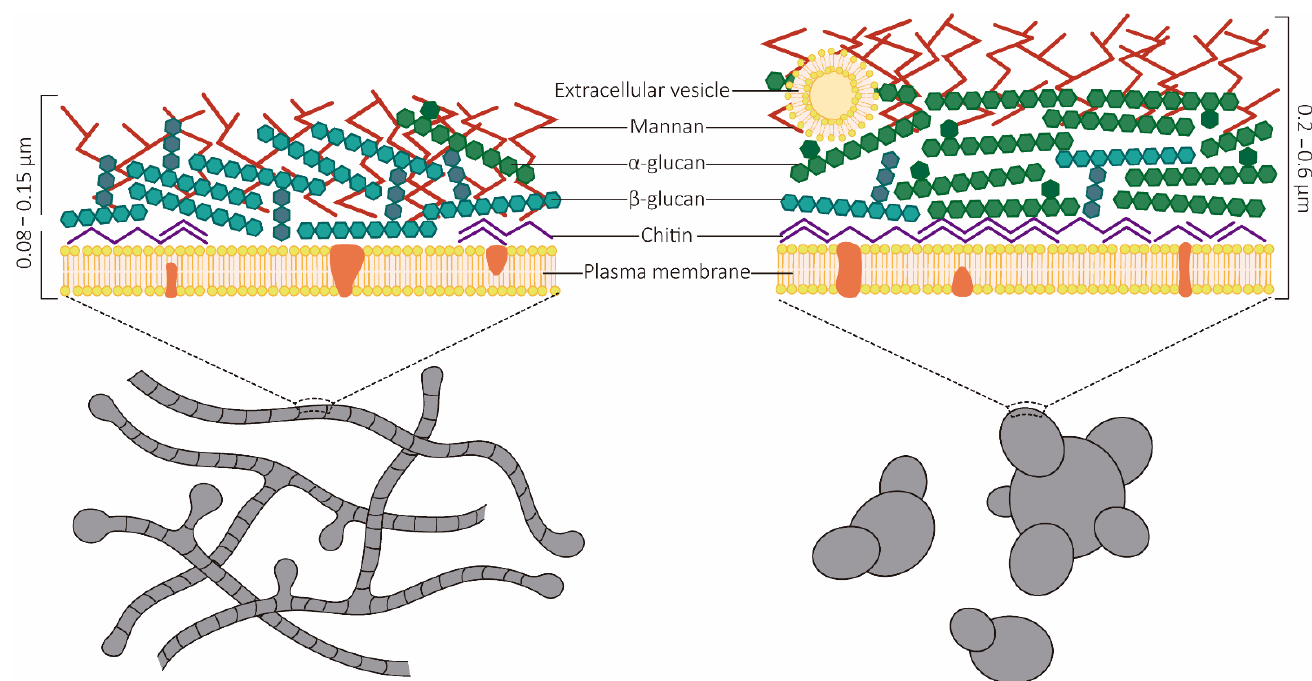
Figure 3. Schematic representation of the Paracoccidioides species cell wall. The ability to perform the dimorphic transition is an essential event for fungal establishment in the host system. This alteration is involved in major changes in the cell wall composition. The thickness of the filamentous form is approximately 0.08 to 0.15 μm, thinner than that of the yeast form, which is approximately 0.2 to 0.6 μm. The cell wall of the filamentous form is composed mainly of polysaccharides, such as β-glucan (most abundant), chitin, and mannan (less abundant). The yeast from the cell wall is constituted mainly of α-glucan and chitin (most abundant) and other polysaccharides, such as mannan. In general, the cell walls of both forms contain smaller proportions of amino acids, lipids, and proteins. The predominance of distinct O-glycosidic bond polysaccharides is essential for host adaptation, as β-glucans are recognized by the dectin-1 receptors of phagocytic cells .